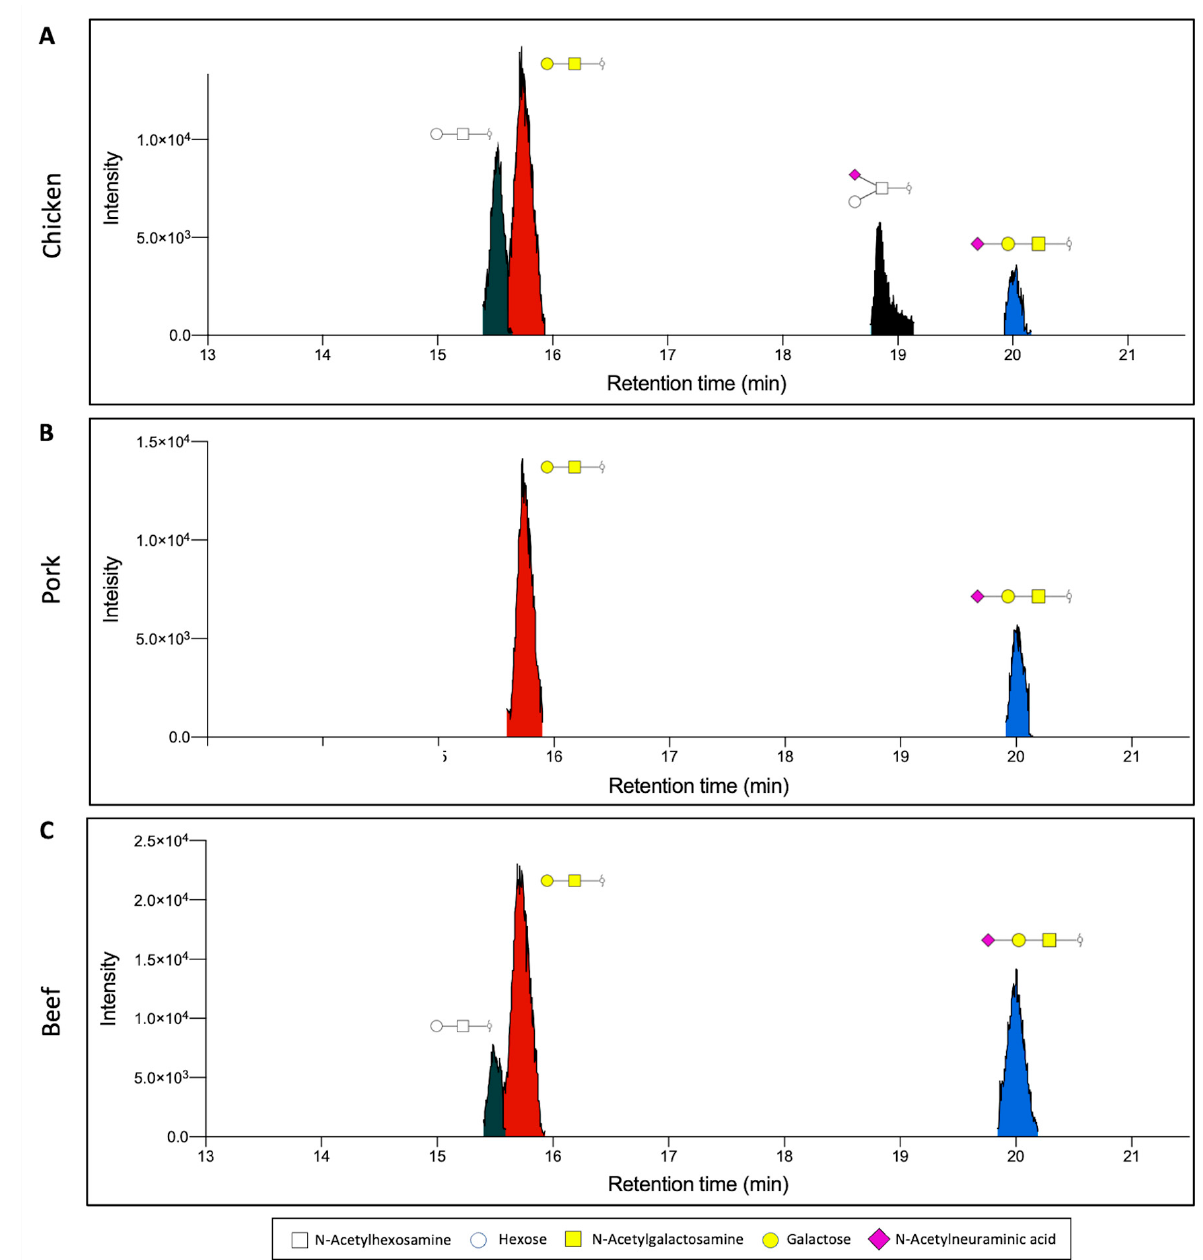
Figure 2. Representative extracted ion chromatogram of permethylated O-glycans extracted from ( A ) chicken, ( B ) pork, and ( C ) beef. Gal-GalNAc and NeuAc-Gal-GalNAc were detected in all species, whilst Hex-HexNAc was detected only in chicken and beef and Hex(NeuAc)HexNAc was detected exclusively in chicken. (White square, N-acetylhexosamine; white circle, Hexose; yellow square, N-acetylgalactosamine; yellow circle, galactose; purple diamond, N-acetylneuraminic acid.)